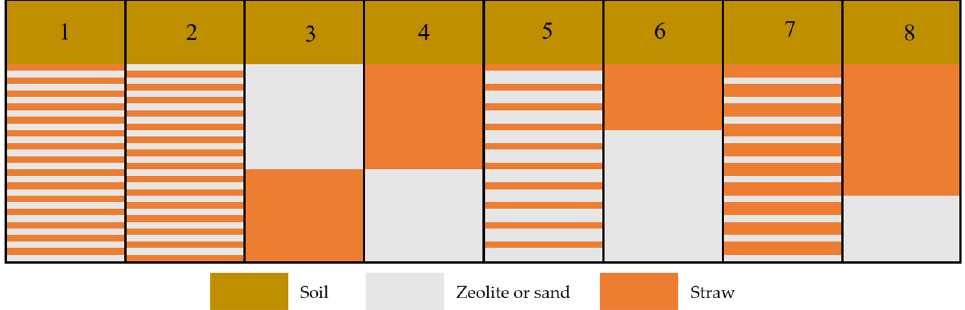
Figure 5. Layout of the mixed filter including straw and zeolite or